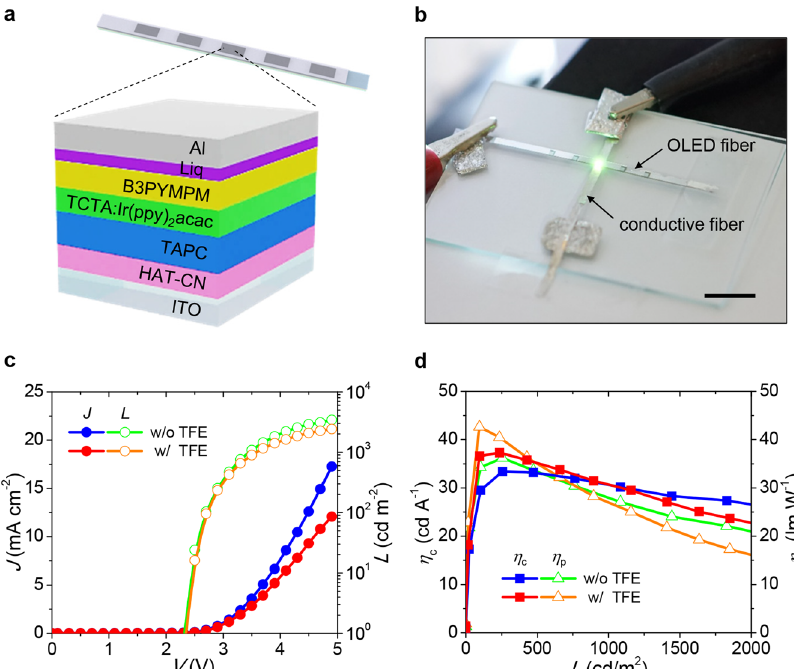
Fig. 2 Electroluminescence performance of encapsulated OLED fi ber pixels. a Schematic illustration of bottom-emission phosphorescent green OLED pixel structure. b Photograph of a fabricated OLED fi ber orthogonally placed on a conductive fi ber for operating its one pixel (scale bar: 1 cm). c Representative current density ( J )-voltage ( V )-luminance ( L ) curves of OLED fi ber pixels with and without TFEs. d Current ef fi ciency ( η c ) and the power ef fi ciency ( η p ) as a function of L for OLED fi ber pixels corresponding to those in c